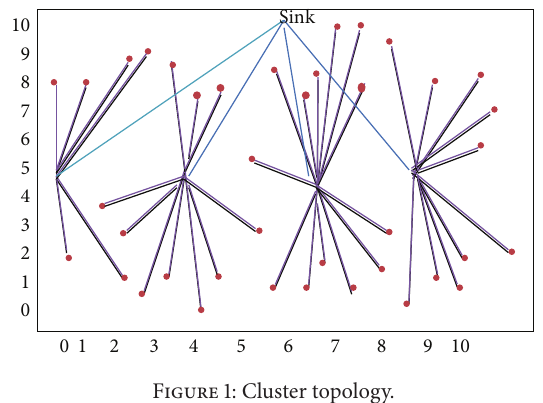
Figure 1: Cluster